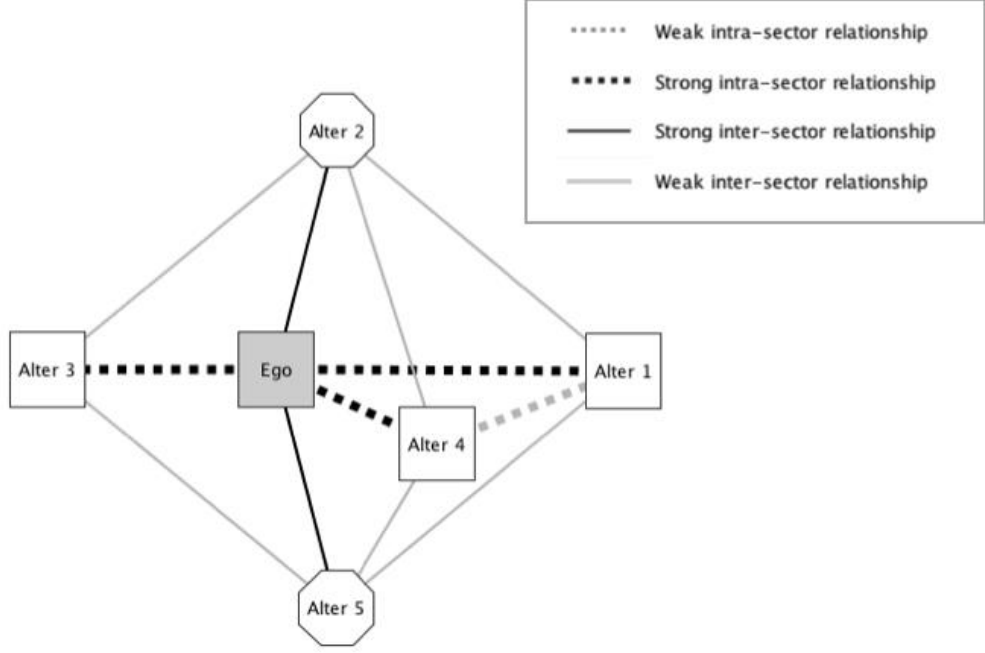
Figure 1. Example of an ego-centric network, showing also Alter–Alter connections.